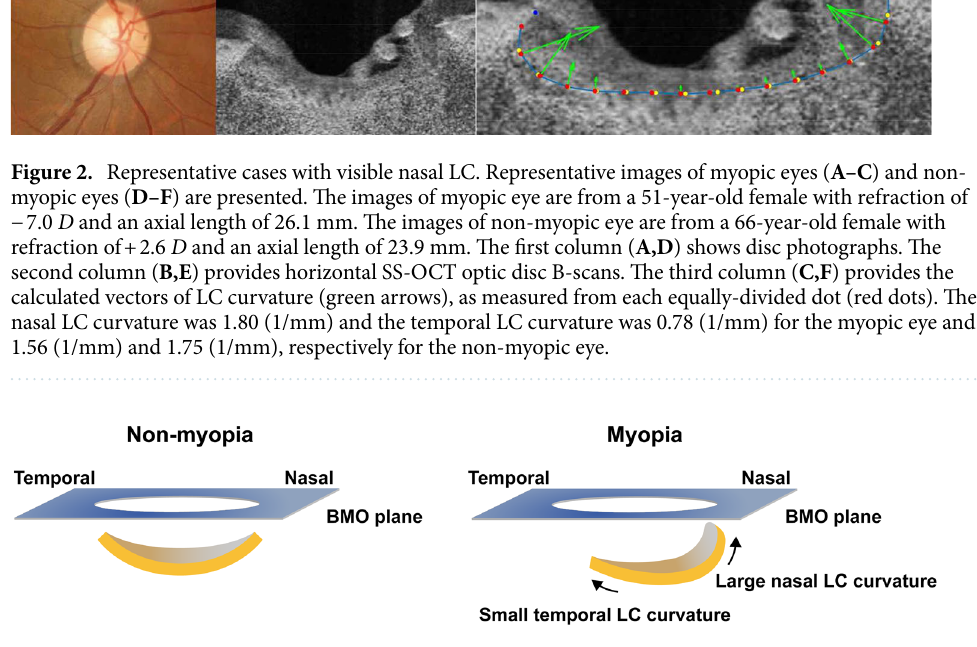
Figure 3. Schematic illustration showing nasal and temporal LC curvature in non-myopic and myopic eyes. Unlike non-myopic eyes, in myopic eyes, the nasal LC curvature shows an abruptly tilted appearance while the temporal LC curvature shows a flattened